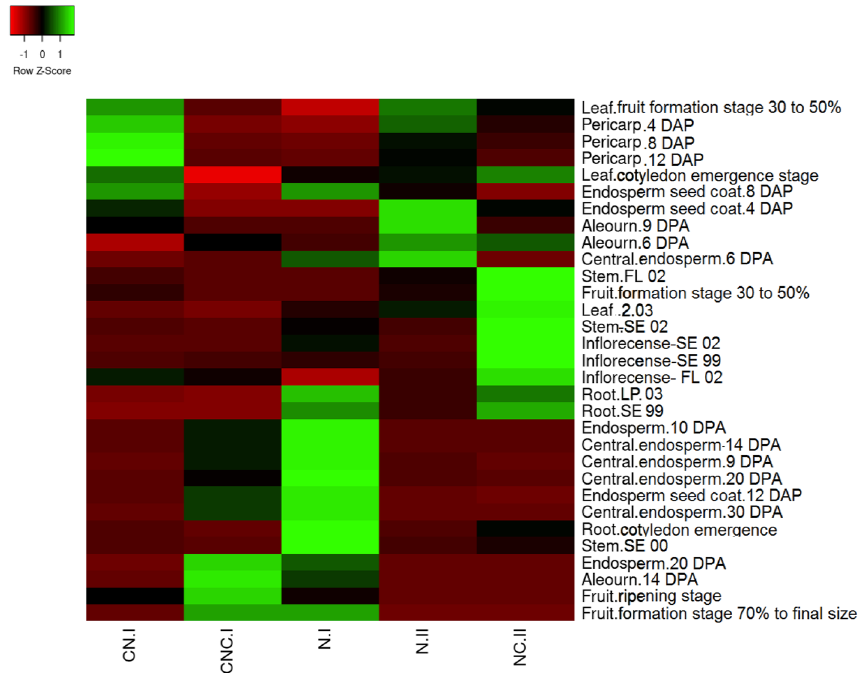
Figure 4. Expression profile of wheat caleosins through different developmental stages 13 . The caleosin classes have been named based on the order of non-cytoplasmic (N) and cytoplasmic (C) domains. Moreover, the phylogenetic clade (I or II) is mentioned next to the name of each caleosin class. DPA: days post-anthesis; DAP: days after pollination.